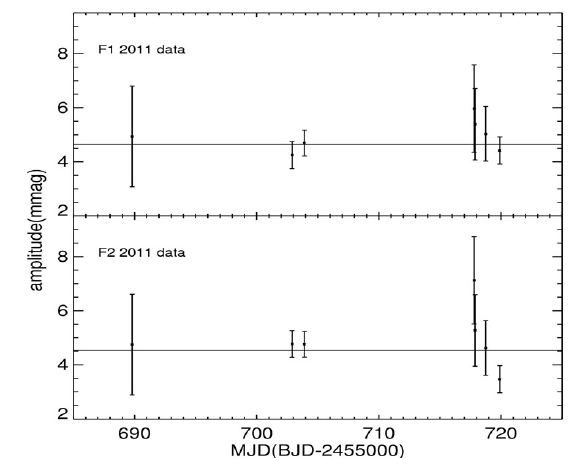
Figure 2. Power spectra for PG 1613+426 obtained from the data of year 2010-2017.